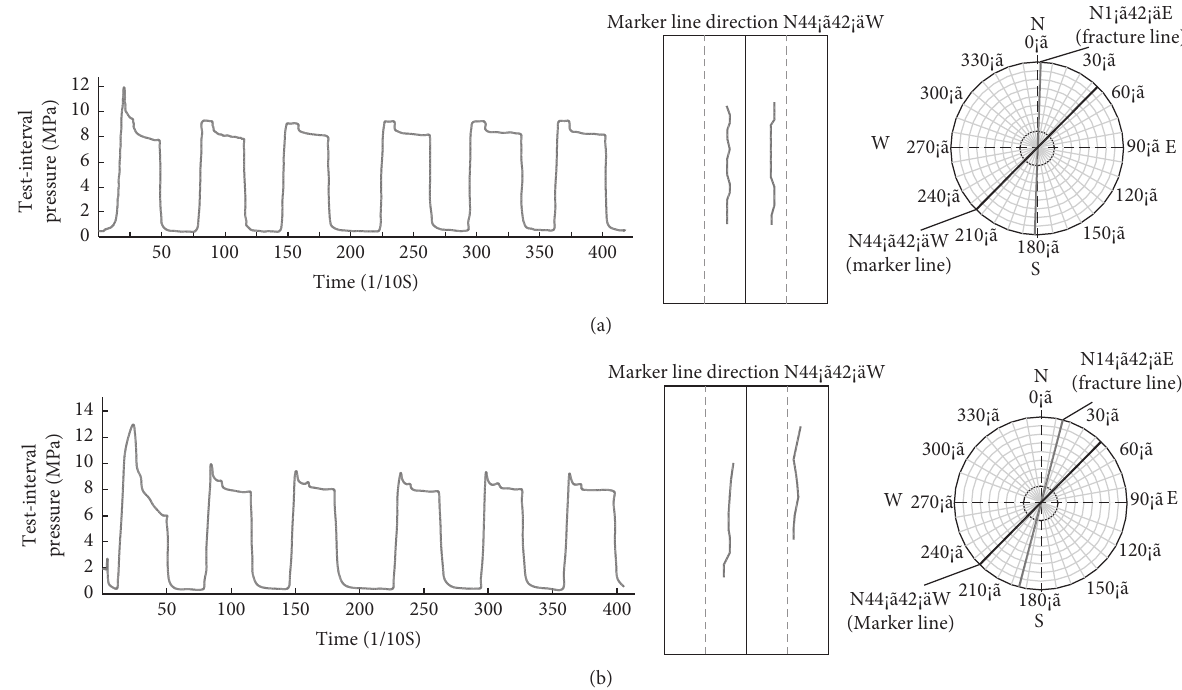
Figure 4: Pressure-time curve and fracturing direction obtained at (a) 1# measuring point and (b) 2# measuring